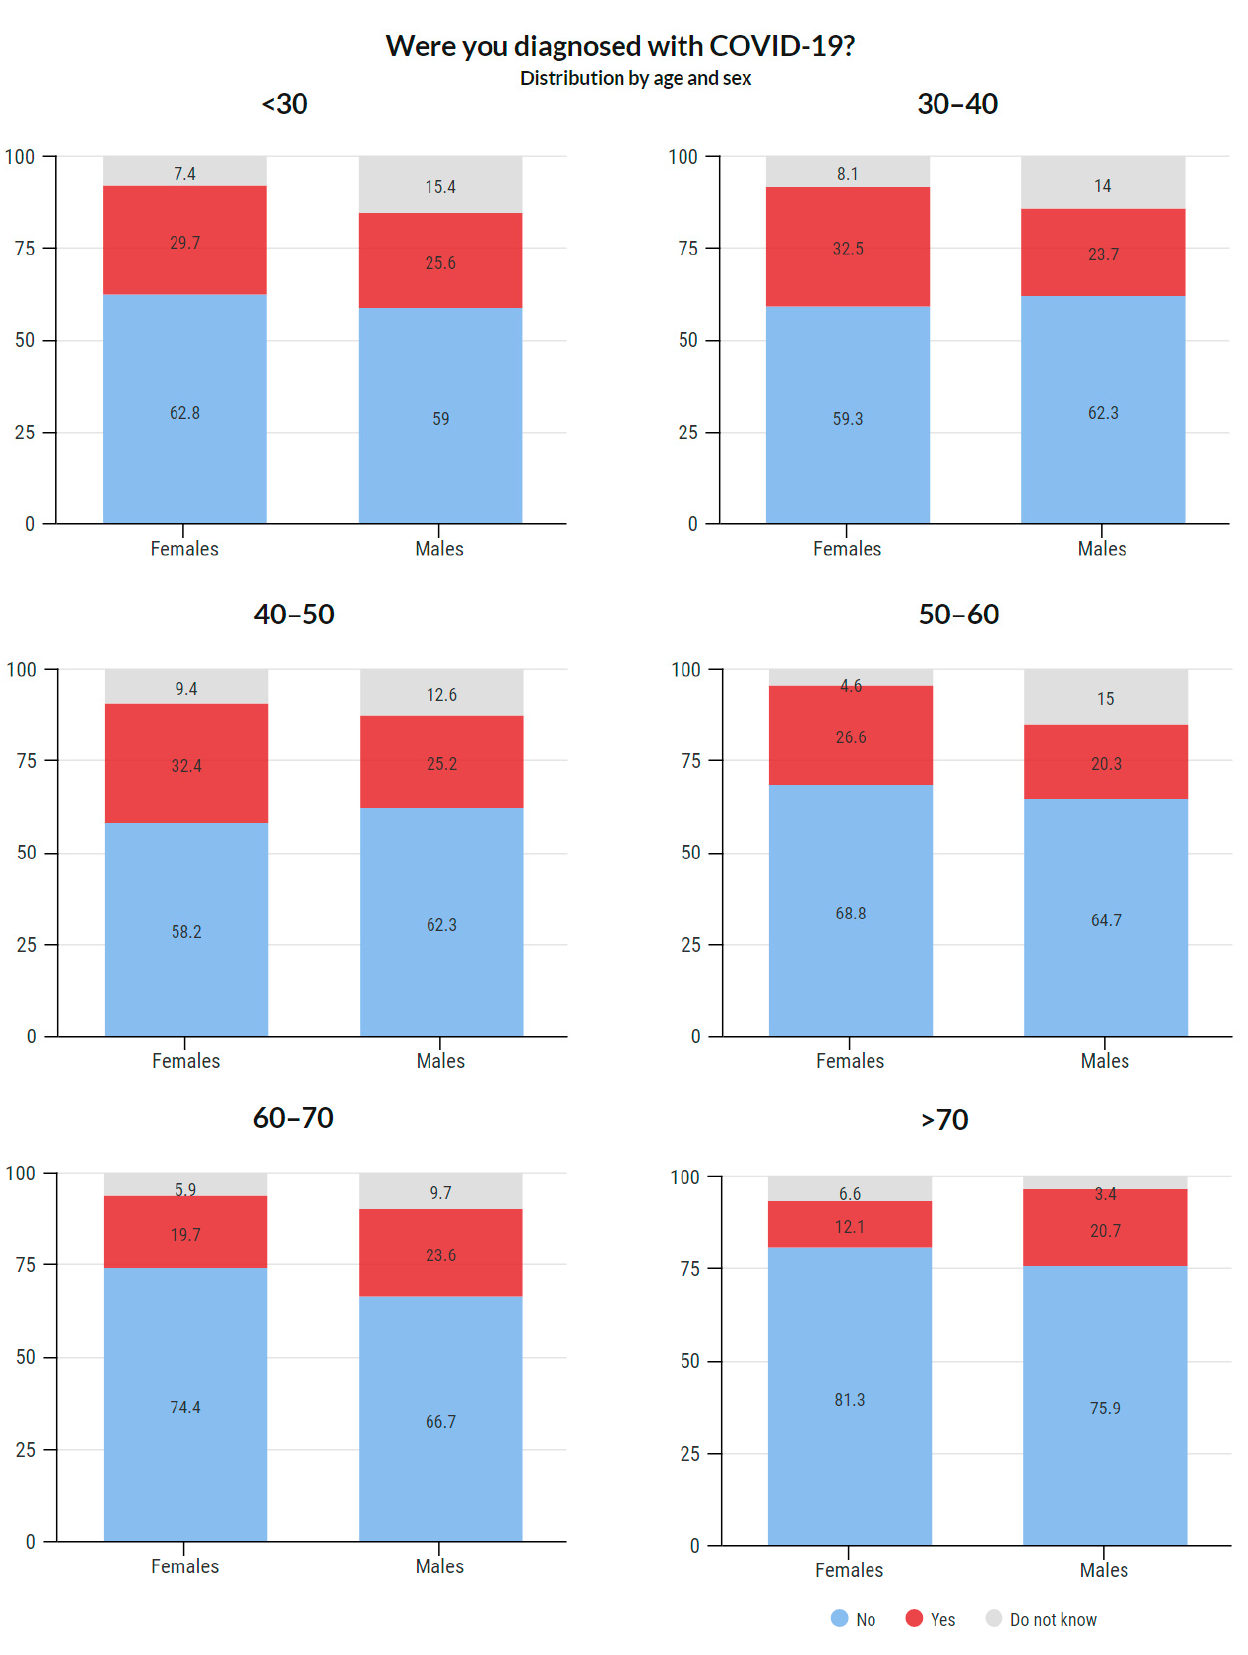
Figure 7. COVID-19 positivity, age and sex distribution.